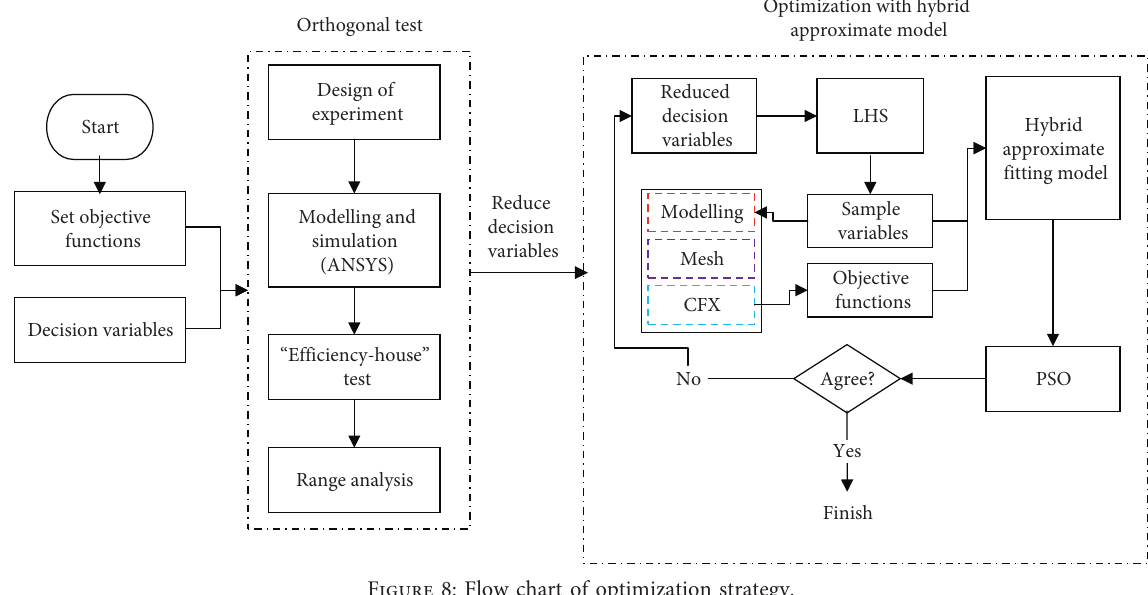
Figure 8: Flow chart of optimization